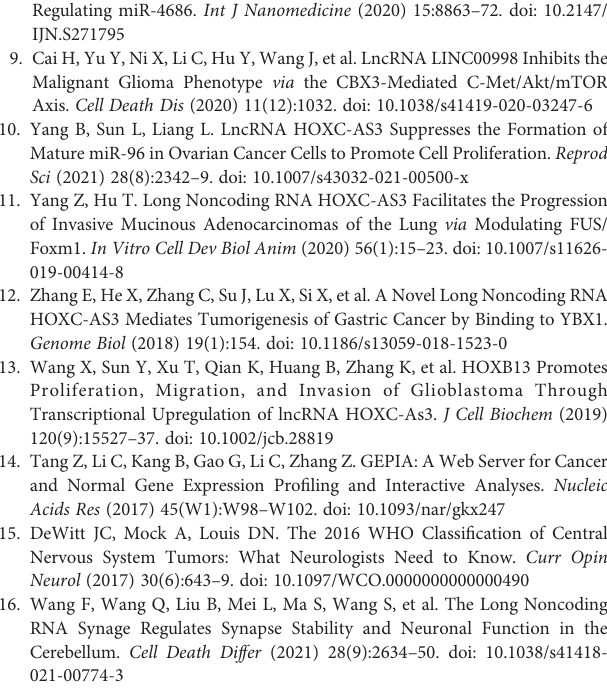
Supplementary Figure 1 | Downregulation of HOXC-AS3 inhibits proliferation, migration, and invasion of glioma in vitro . (A, B) qRT-PCR was used to test the